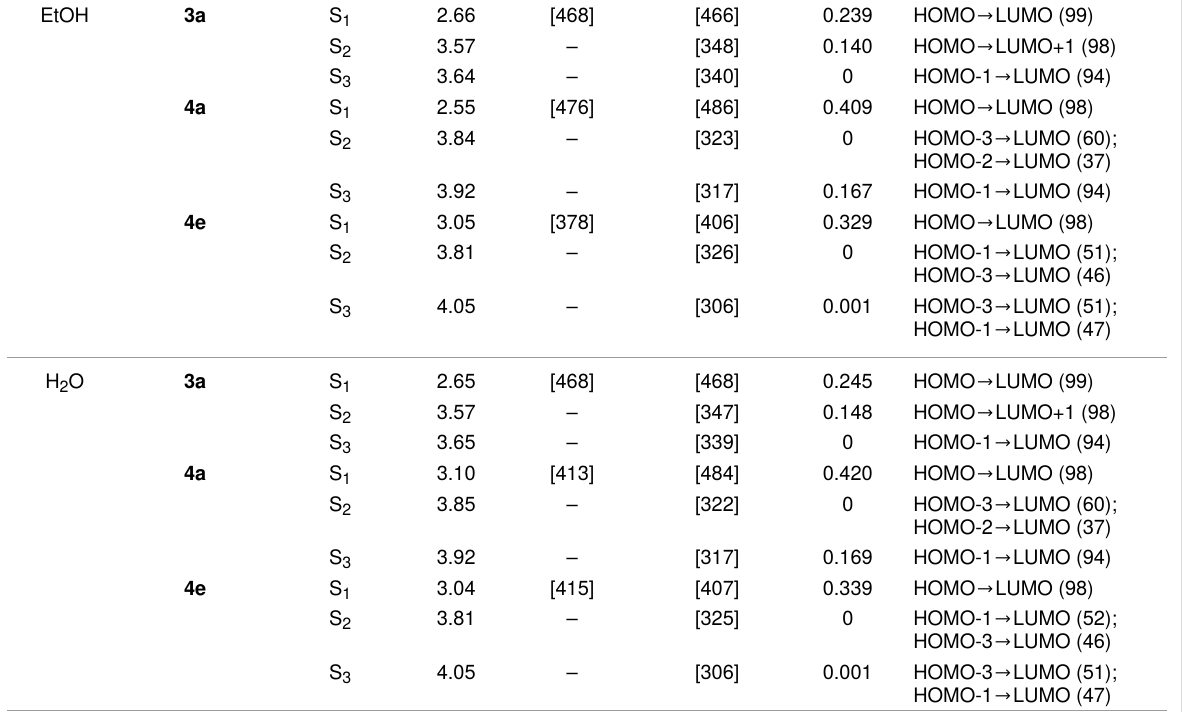
Table 4: Calculated excitation energies ( E [Ex max ]), oscillator strengths ( f ), and main components of the transition of the three lowest excited states for compounds 3a , 4a , and 4e using the TD-B3LYP/6-311+G(d,p)//B3LYP/6-31G(d,p) level of theory. (continued)